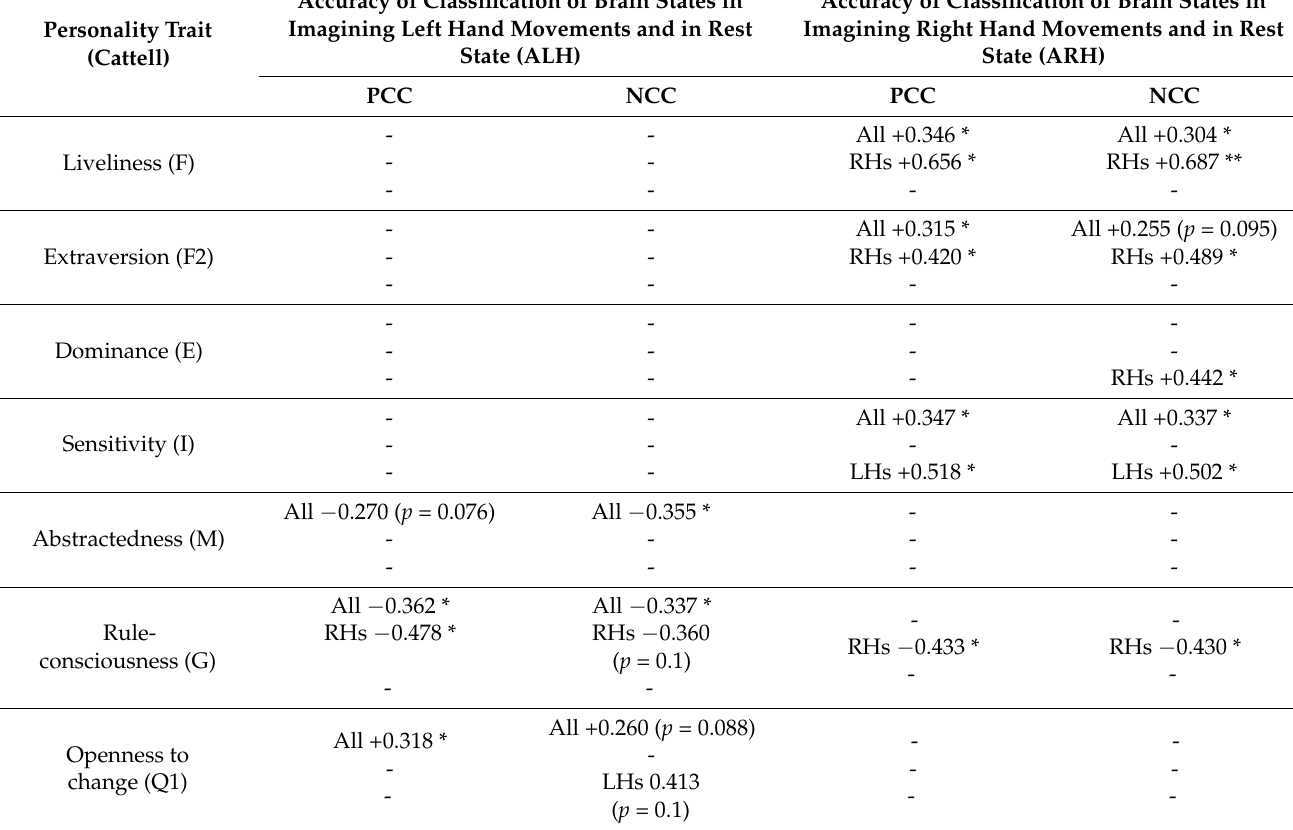
All—the correlation coefficient for the group of all of the subjects, RHs—for right-handers, LHs—for left-handers. PCC—the value of the parametric correlation coefficient (Pearson), NCC—nonparametric correlation coefficient (Spearman). Significant correlations are marked with an asterisk (*) ( p < 0.05) or two asterisks (**) (for p < 0.01), p -value is indicated in parenthesis in a case of trend.